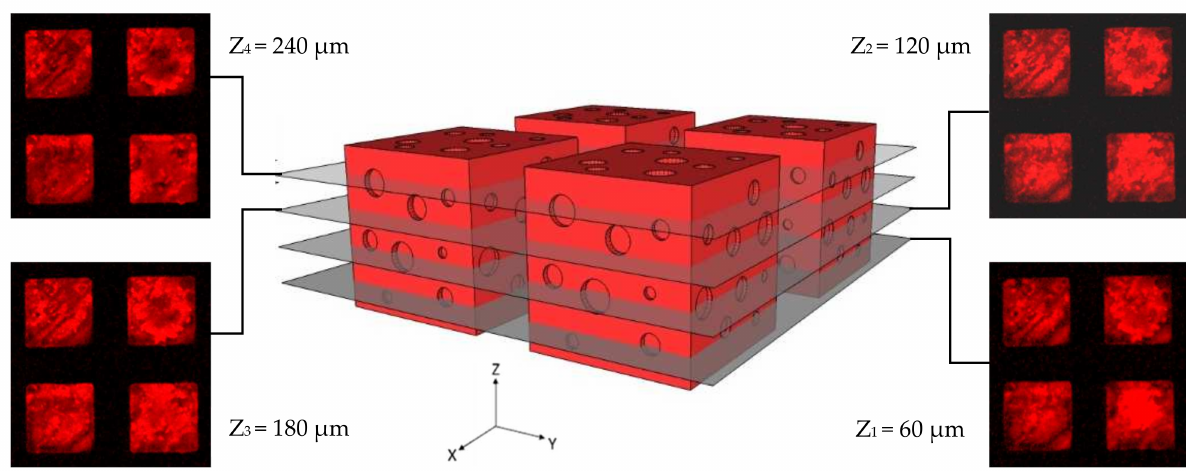
Figure 6. The fabricated porous methyl propiolate-functionalized poly- p -xylylene exhibited interface chemistry that can undergo a copper-free azide-alkyne click reaction by the conjugation of Alexa Fluor-555 ® azide to the equipped alkyne conductor. CLSM images recorded in varied positions along the Z -axis show the fluorescence signals at the interfaces of the three-dimensional structure and confirmed that the biorthogonal click reaction was performed. Scale bars are 200 µ